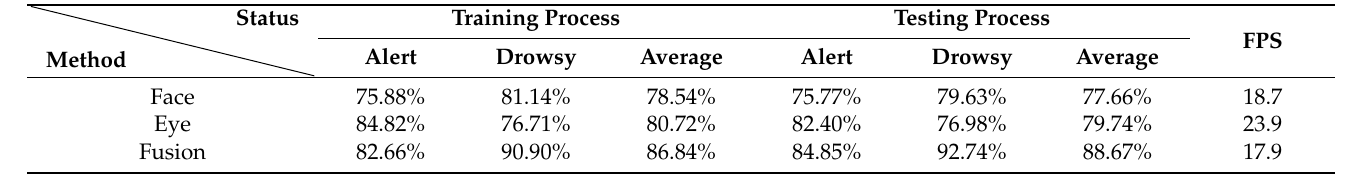
Table 3. The accuracy rate and frame per second of the experiment with the operation point of 0.5.